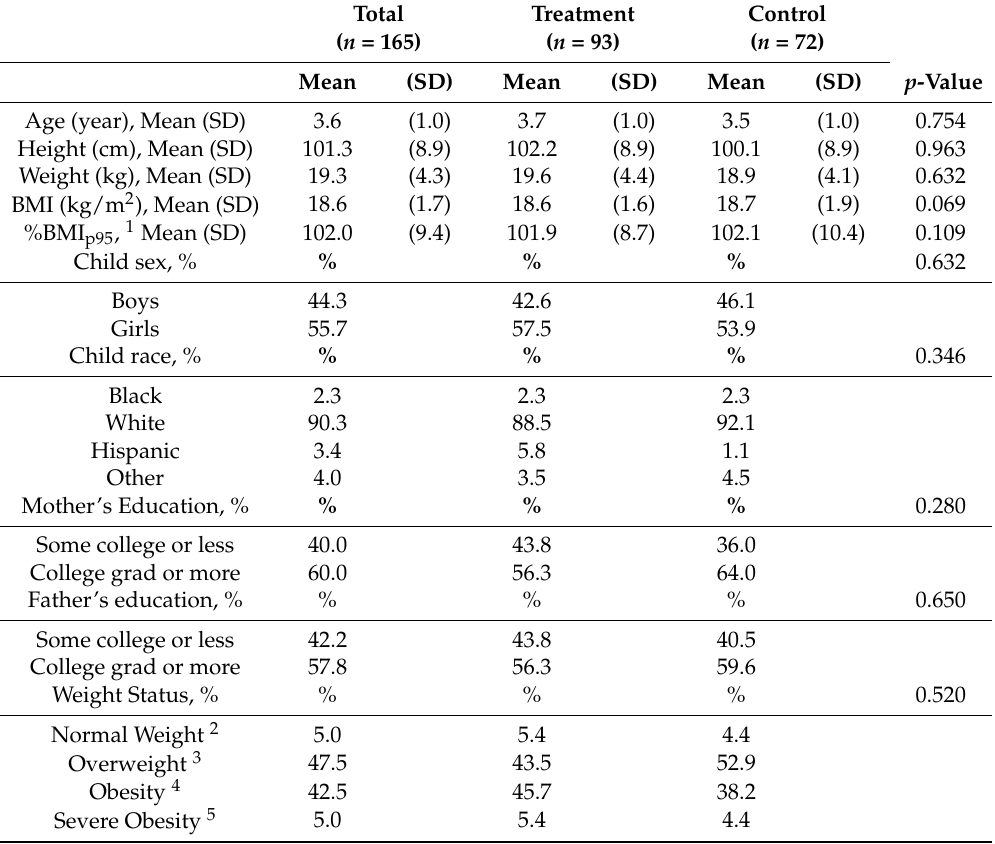
Table 1. Baseline patient characteristics among children 2–5 years participating in a primary care weight management program. Total